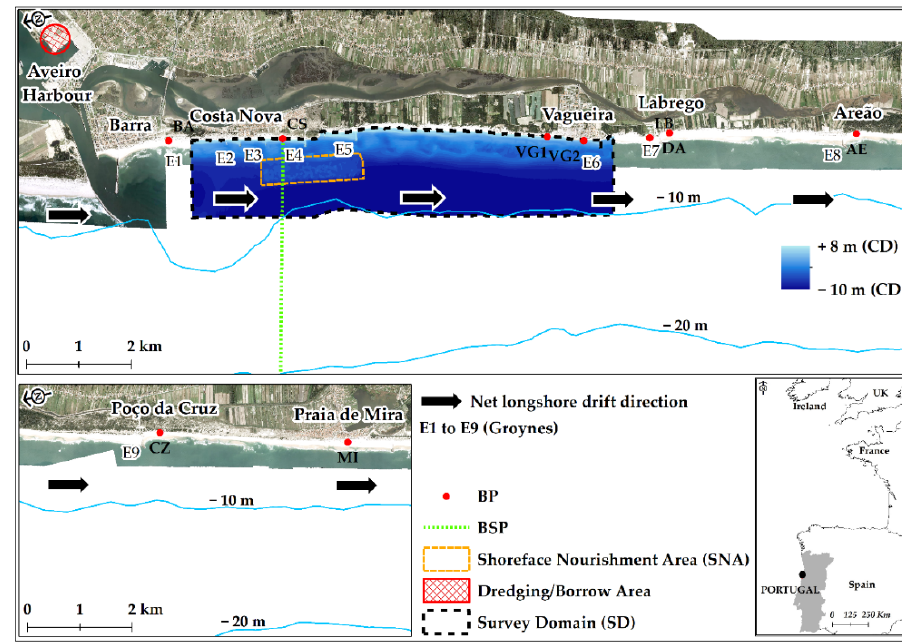
Figure 1. Location of study area with detailed position of the dredging/borrow area and shoreface nourishment area (SNA). Beach profiles (BP), Beach shoreface profiles (BSP), and topo-bathymetric surveys (TBS) in the survey domain (SD) and southward until Praia de Mira.